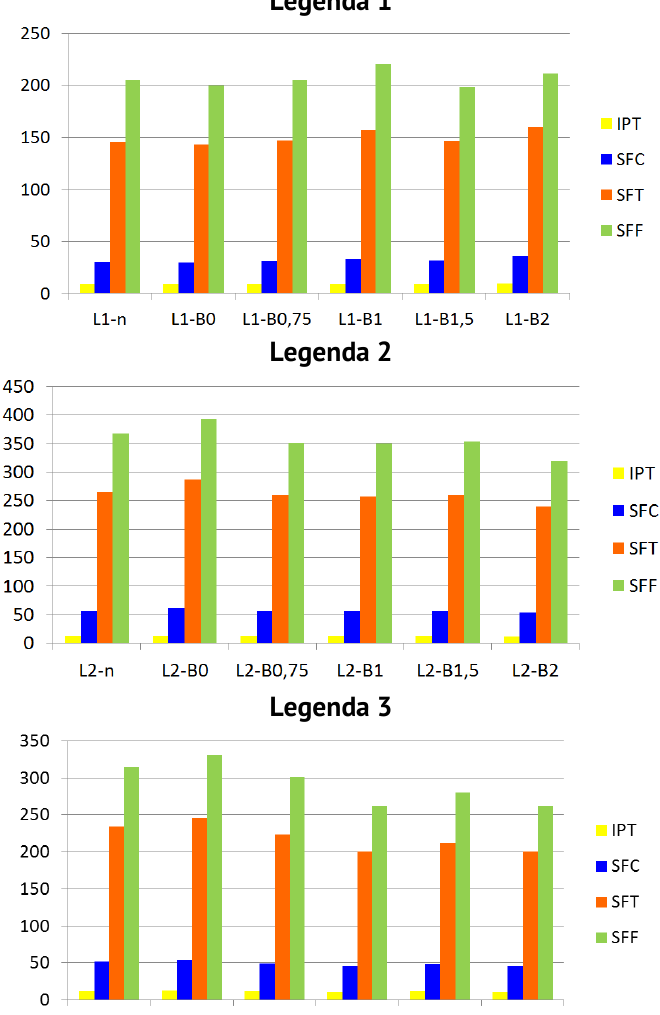
Figure 5. The impact of increasing doses of bentonite on total polyphenol index (IPT) and main groups of phenolic compounds in Legenda